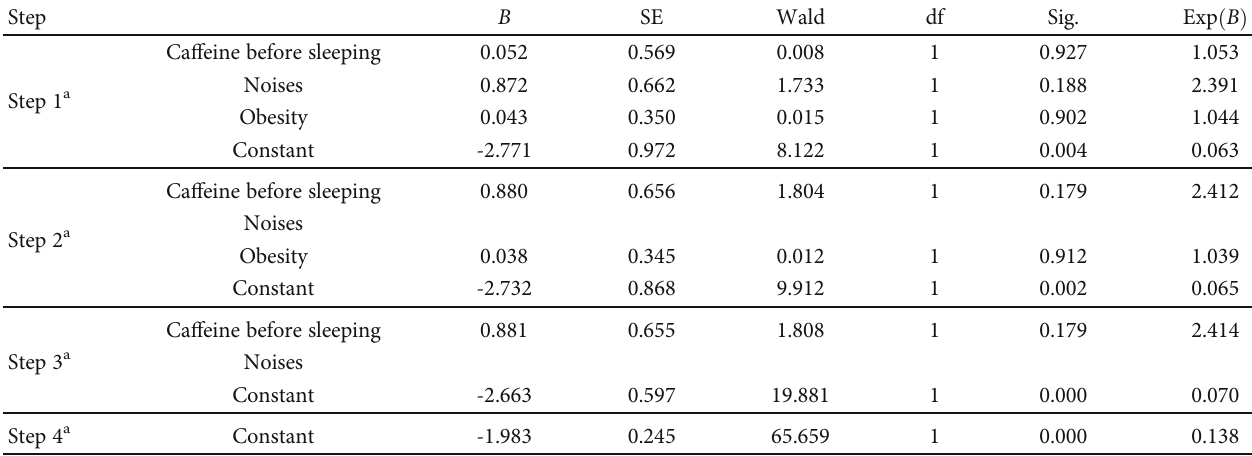
Table 5: Multivariate analysis of confounding